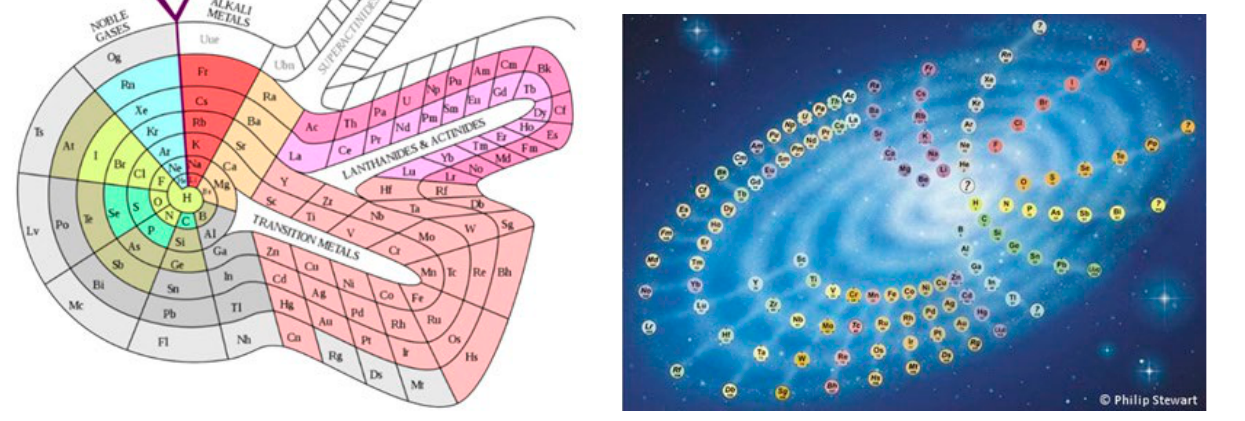
Figure 14. The ‘snail’ periodic table. Figure 15. The Galaxy periodic